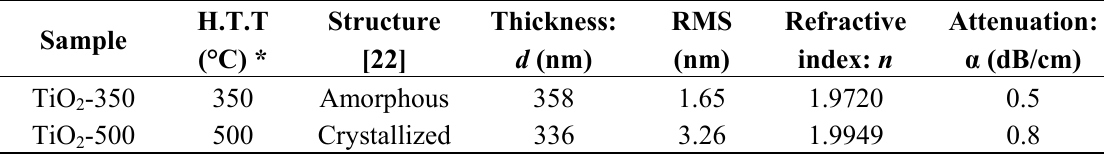
Table 2. Comparison of films characteristics. The refractive indices and attenuation values are given for the fundamental TE